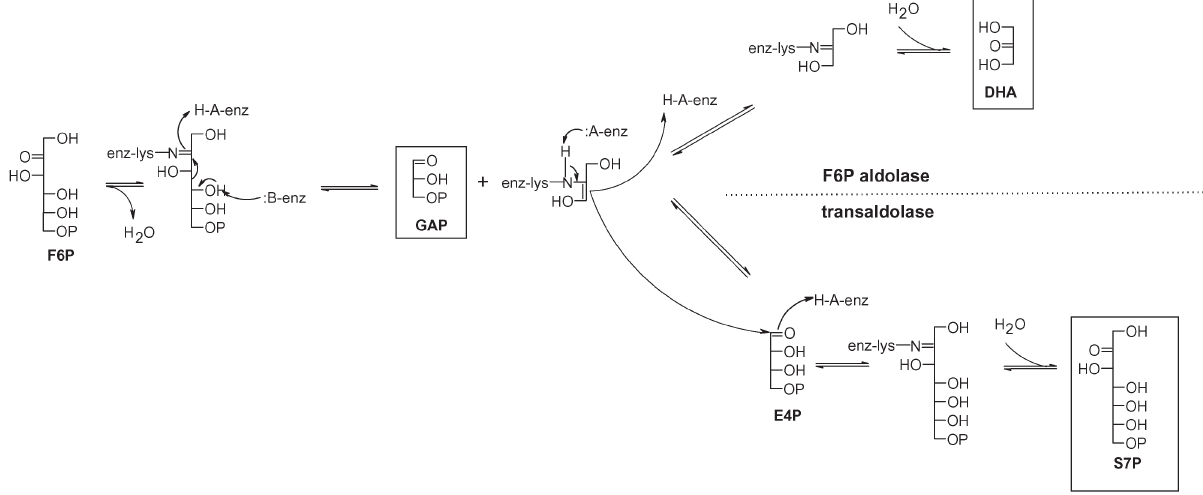
Figure 1. Comparison of the probable reaction mechanisms of fructose-6-phosphate aldolase and transaldolase. Aldolase cleaves the fructose- 6-phosphate substrate directly into glyceraldehyde-3-phosphate and dihydroxyacetone, whereas transaldolase requires an aldose substrate (such as erythrose-4-phosphate) to which it transfers the dihydroxyacetone group. Abbreviations: F6P = fructose-6-phosphate; GAP = glyceraldehyde- 3-phosphate; E4P = erythrose-4-phosphate; S7P = sedoheptulose-7-phosphate; and DHA =